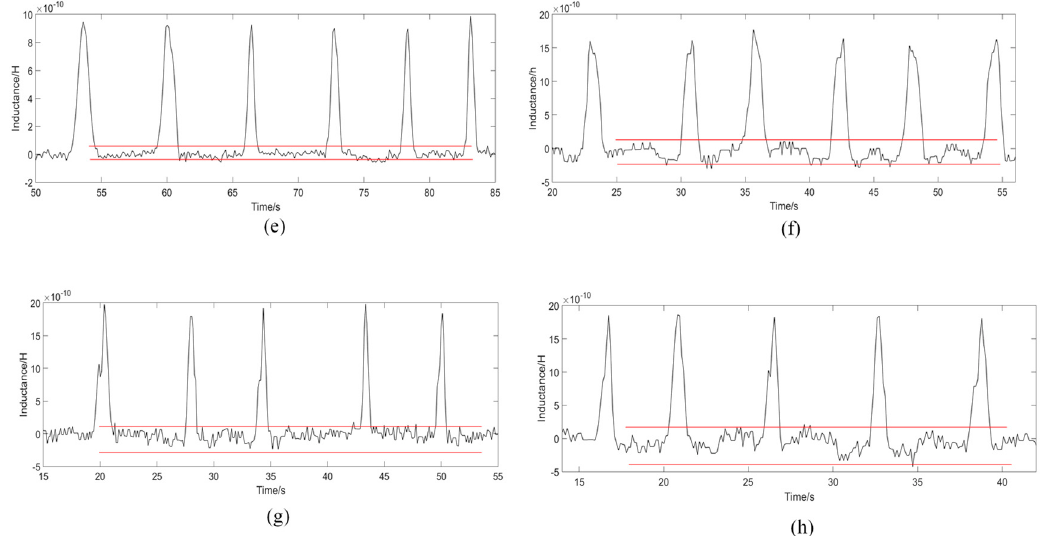
ff erent solenoid coils on 40 µ m iron particles, ( a – h ) is